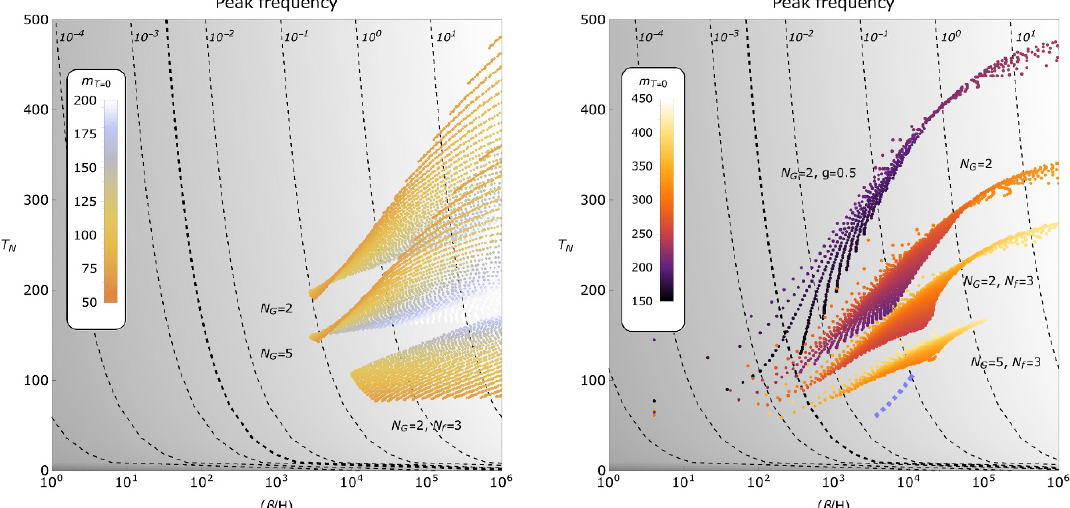
Figure 4 . Thermal parameters from the PT described by Eqs (2.5) and (2.7) respectively. The dashed contours in the plots correspond to the sound wave peak f sw (4.11), where we have chosen the wall velocities as in (cid:12)gure 3. The thicker dashed contour corresponds to the LISA frequency peak [60]. Note that the EWPT results do not overlap with our scans, since the nucleation tem- perature T N is sensitive to the scale